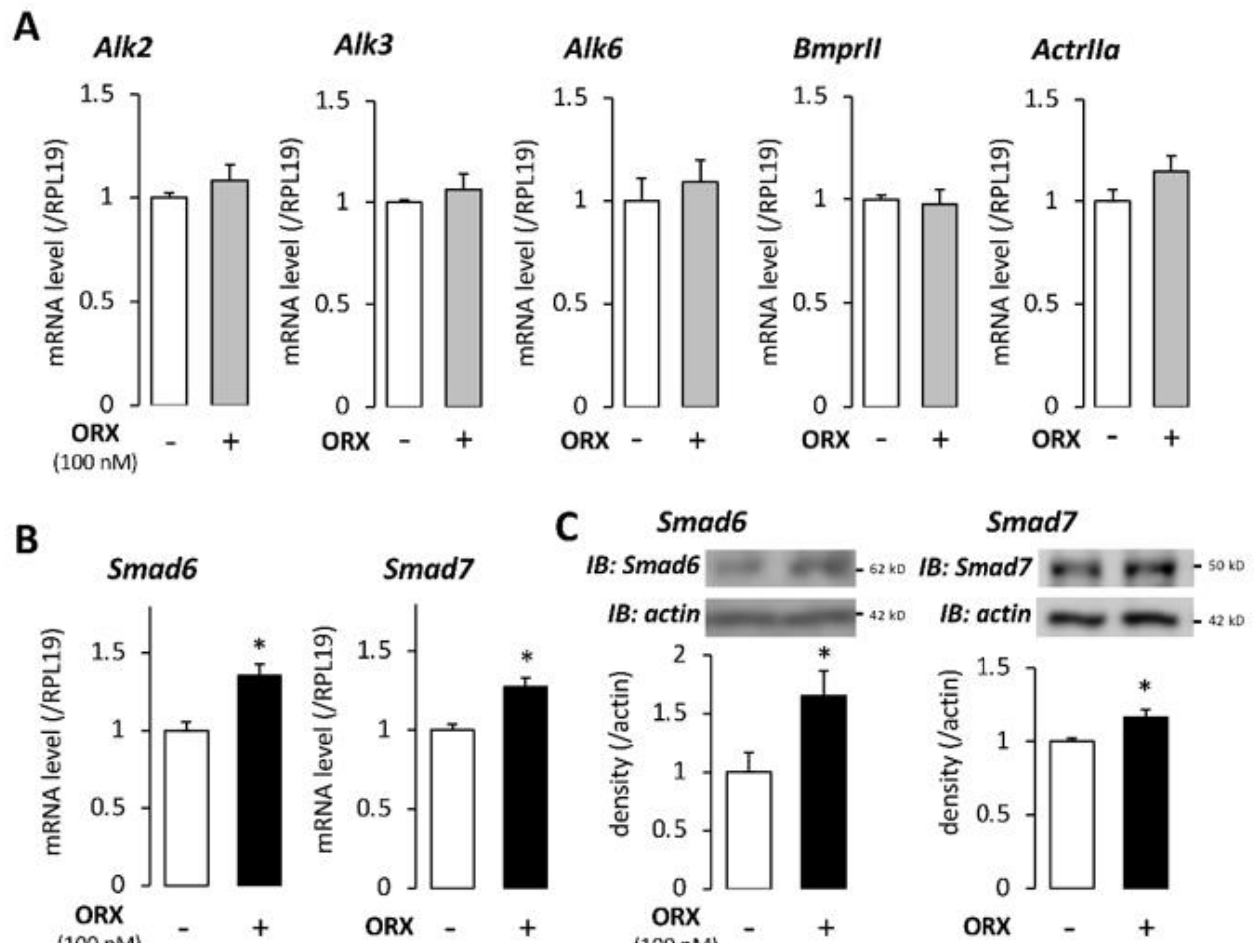
Figure 3. Effects of orexin A on the expression of BMP-receptor signaling molecules in AtT20 cells. ( A , B ) AtT20 cells treated with orexin (ORX) for 24 h were extracted, and the mRNA expression levels of Alk2, Alk3, Alk6, BmprII, ActrIIa ( A ), Smad6, and Smad7 ( B ) were quantified by qPCR. The expression levels of target genes were standardized by the RPL19 level in each sample. ( C ) Cells were treated with ORX in serum − free media for 24 h. The cell lysates were subjected to immunoblot (IB) analysis using antibodies that detect Smad6, Smad7, and actin. Results are shown as means ± SEM of data from at least three independent experiments. Statistical analysis was performed by the unpaired t -test. * p < 0.05 vs. between the control groups.